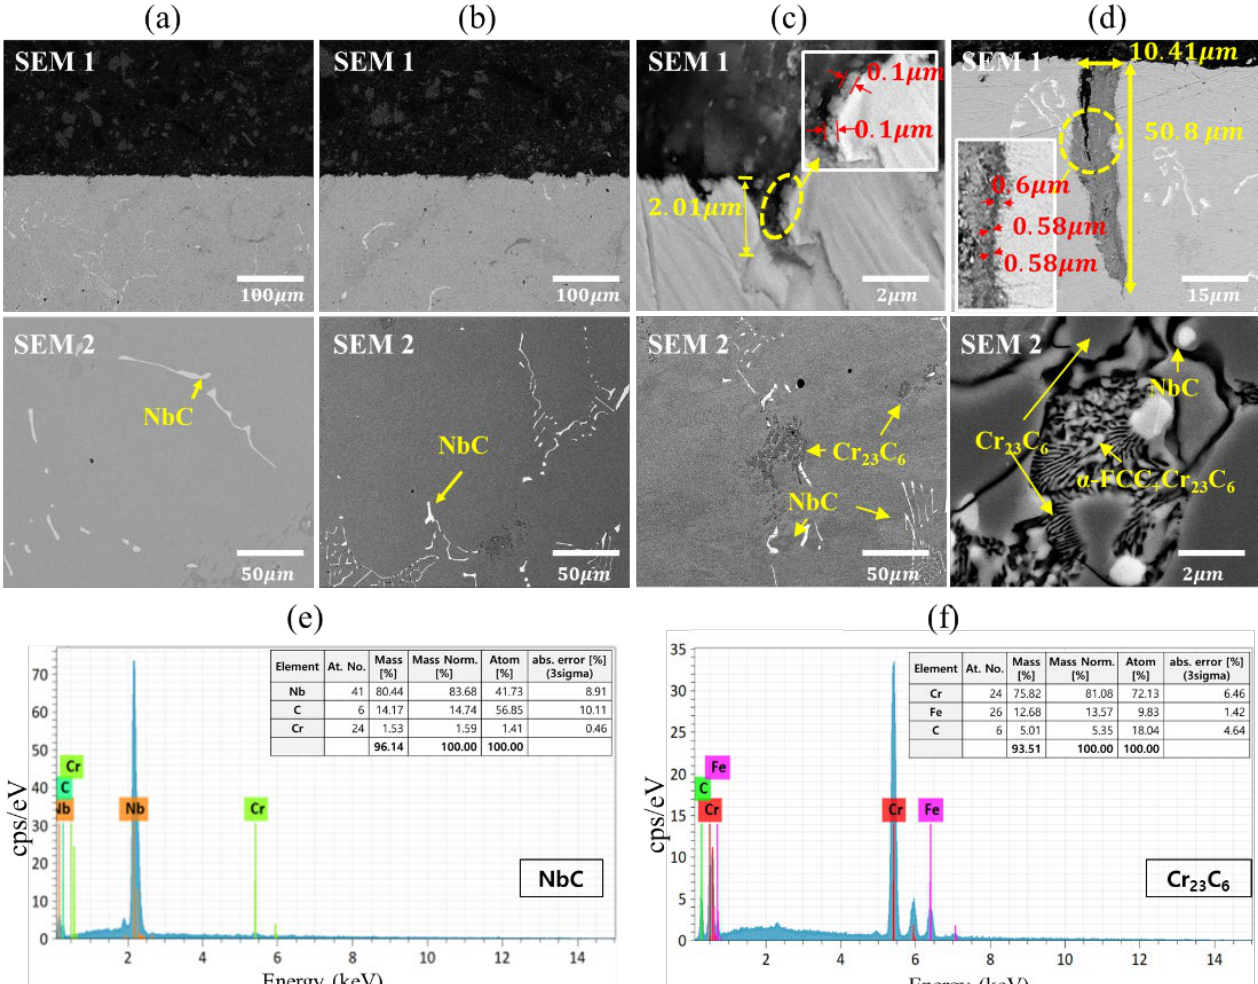
Figure 5. SEM-back scattered electron image of oxidation damage (SEM 1) and carbide precipitation (SEM 2) after the 0.4% strain amplitude LCF tests at ( a ) 200 °C; ( b ) 400 °C; ( c ) 600 °C; ( d ) 800 °C and EDS analysis of carbide precipitation of ( e ) NbC; ( f ) Cr 23 C 6.